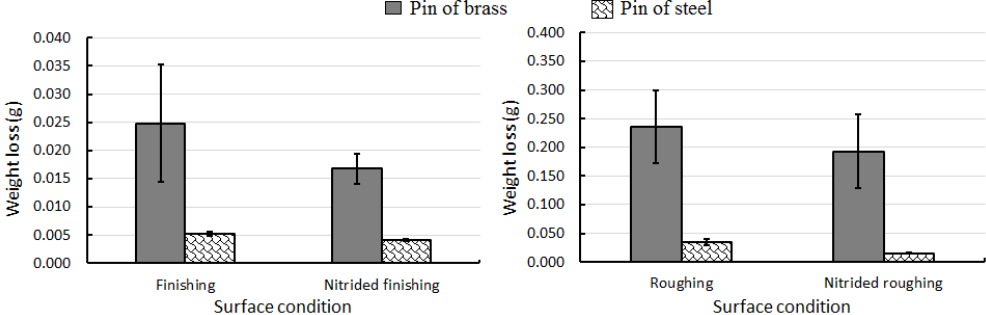
Figure 5. Weight loss of the pins made of brass and steel after the pin-on-discs test in the following surface conditions: finishing ( left ) and roughing ( right ) EDM conditions with and without nitriding. The weight loss values show that the average weight loss is about 1.22 to 2.32 times higher for brass and steel when comparing non-nitrided discs versus nitrided ones. The lowest surface